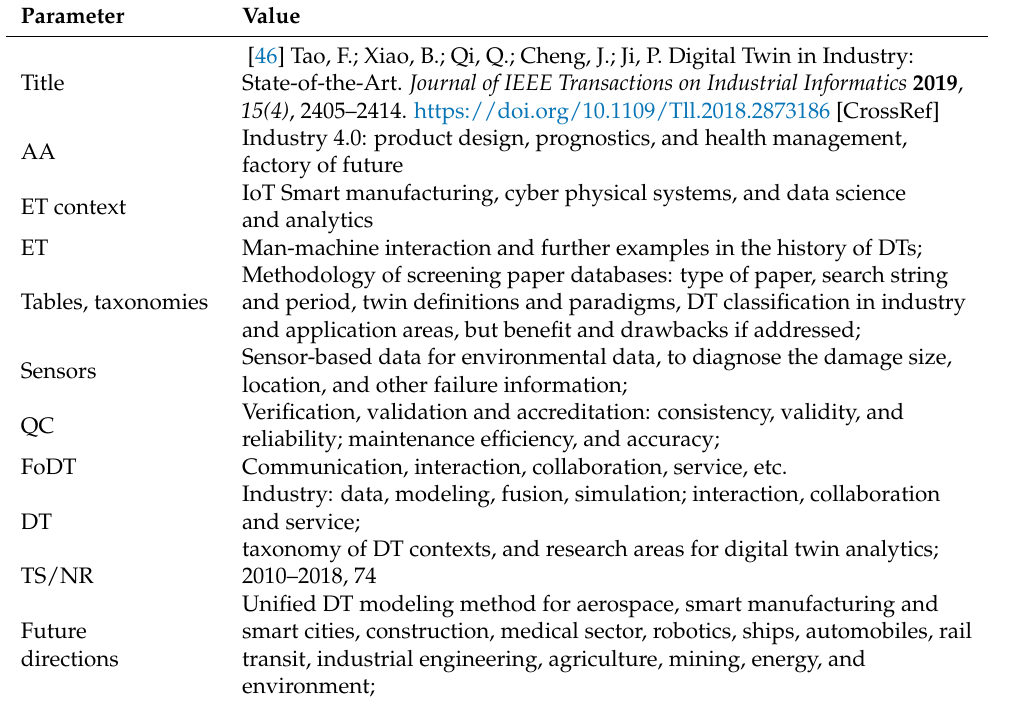
Table 1. Publication data sheet for reference und corpus